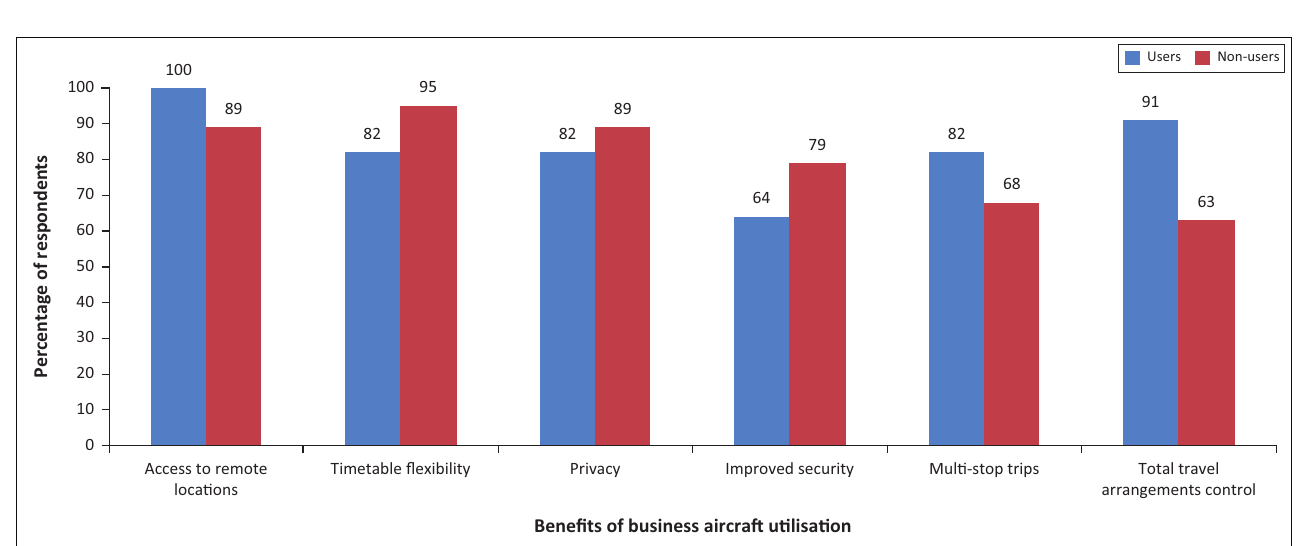
FIGURE 2: Benefits of utilising business aircraft ( n = 30).